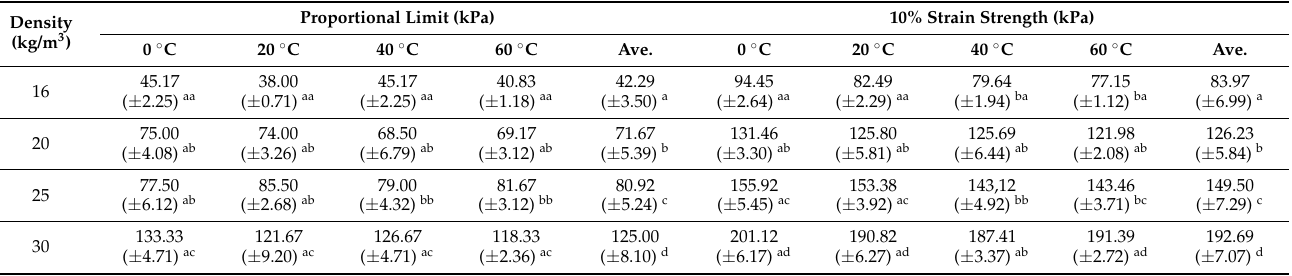
Table 1. Proportional limit and 10% strain strength of EPS, for different density and temperature